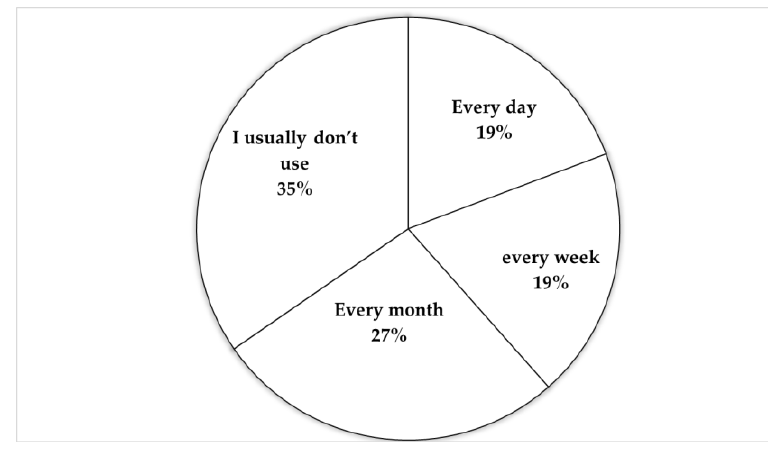
Figure 6. The using pattern of the new train station, source: field survey, May, 2019.